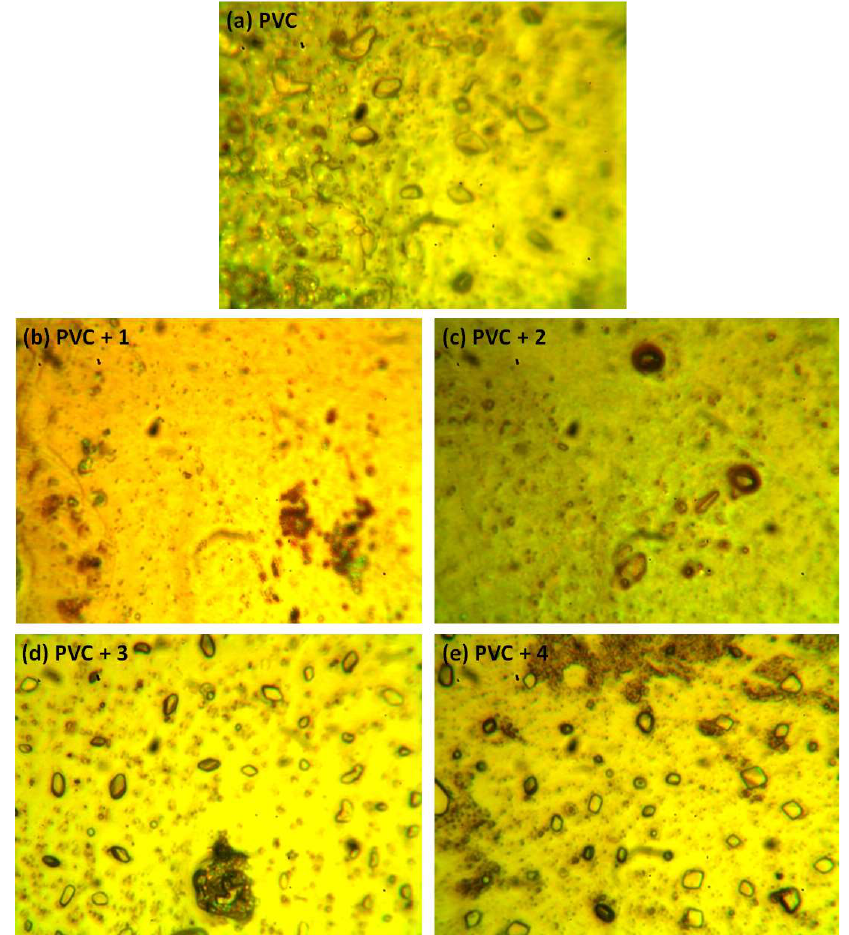
Figure 10. Optical microscopic images of the ( a ) blank PVC film and ( b – e ) PVC films containing tin(IV) compounds 1 – 4 after irradiation (300 h).